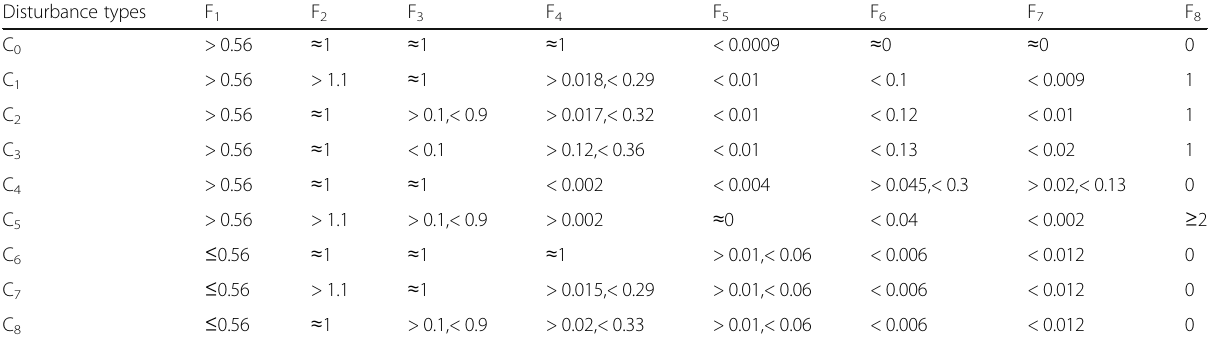
Table 1 Analytical comparison of the disturbances and feature